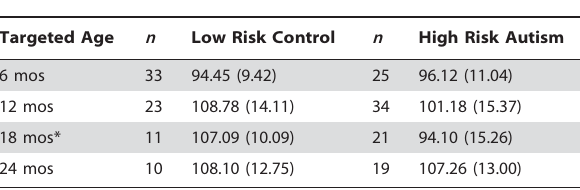
mother and father’s age at the infant’s birth. None of these variables had significant effects for any of the frequency bands and therefore were not included in the model. Thus, the hypothesized model was: